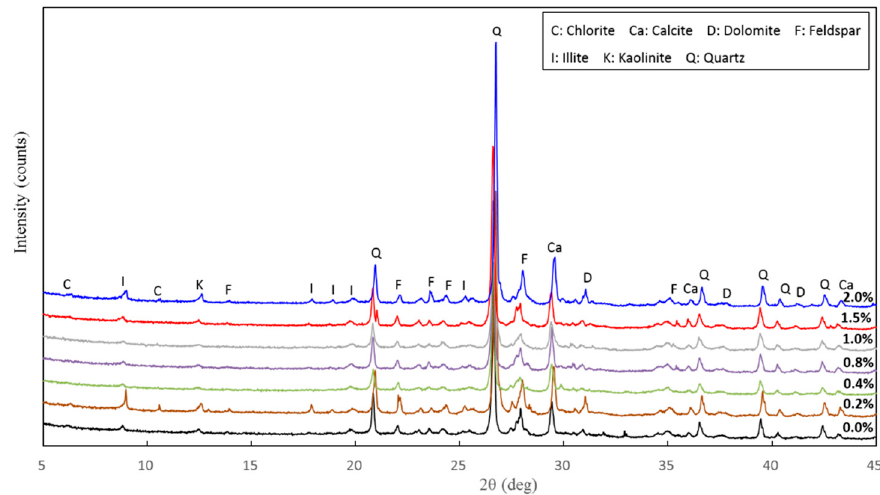
Figure 11. Mineralogical composition of the treated loess with different nano-SiO 2 contents after curing for 7 days.